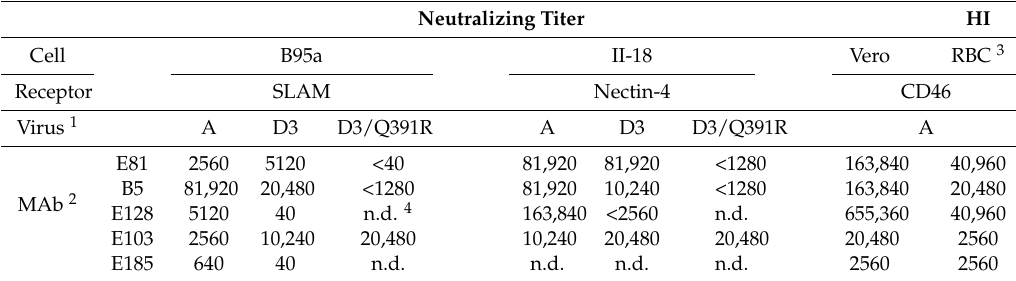
Table 2. Neutralizing titers and hemagglutination-inhibiting (HI) titers of MAbs.